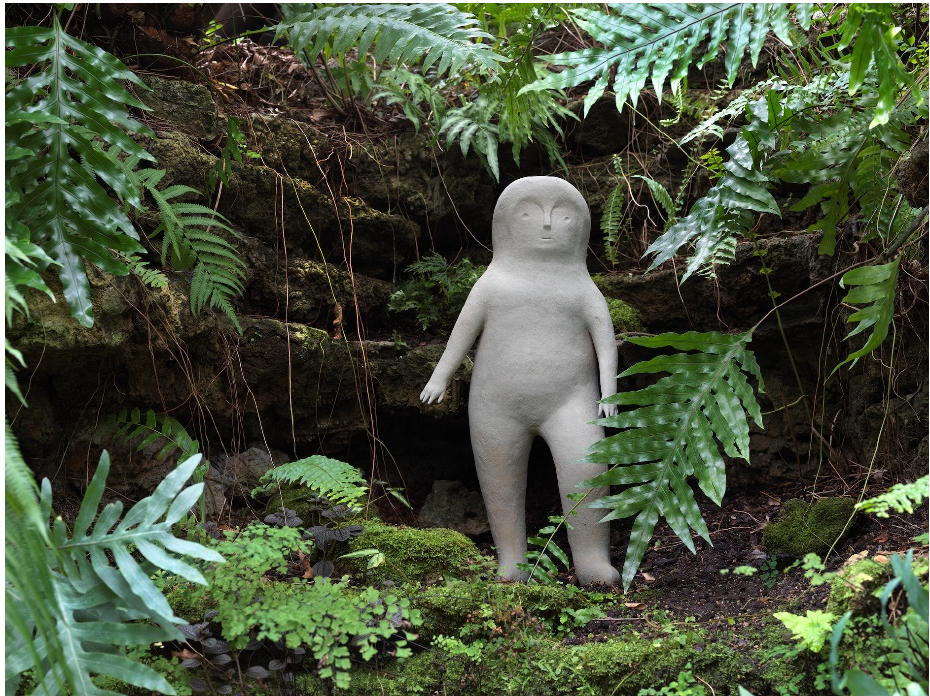
Figure 1. A Genius of the Spot I, 2020, glazed ceramic, 28 ″ × 13 ″ × 10 ″ .